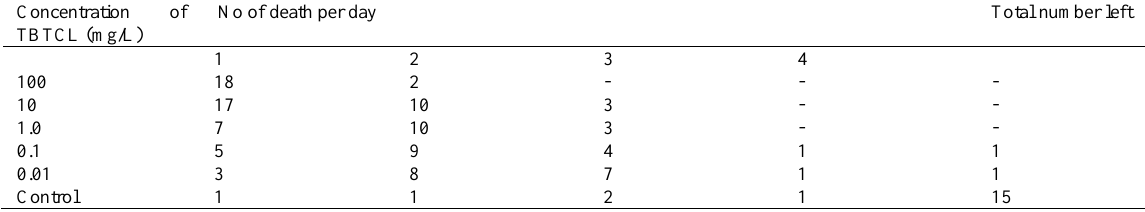
Table 1.Toxicity test of TBTCL on Shrimps for 96hs